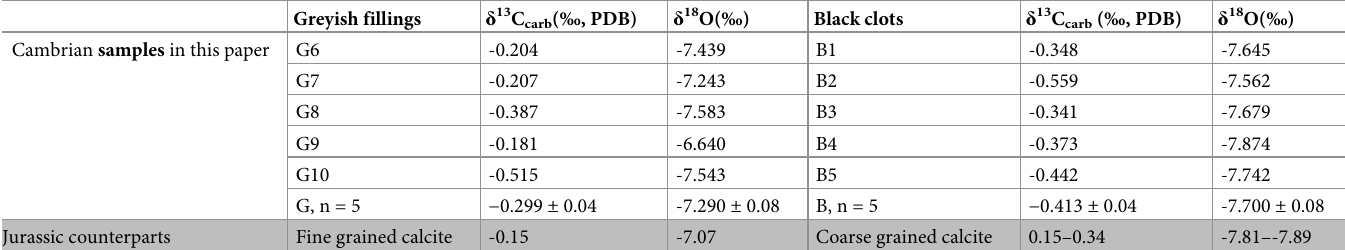
Table 1. δ 13 C and δ 18 O for black clots (B) and greyish fillings (G) of the Cambrian thrombolites (Sampling points are shown in Fig 3A and 3B), and the Late Jurassic calcified counterparts